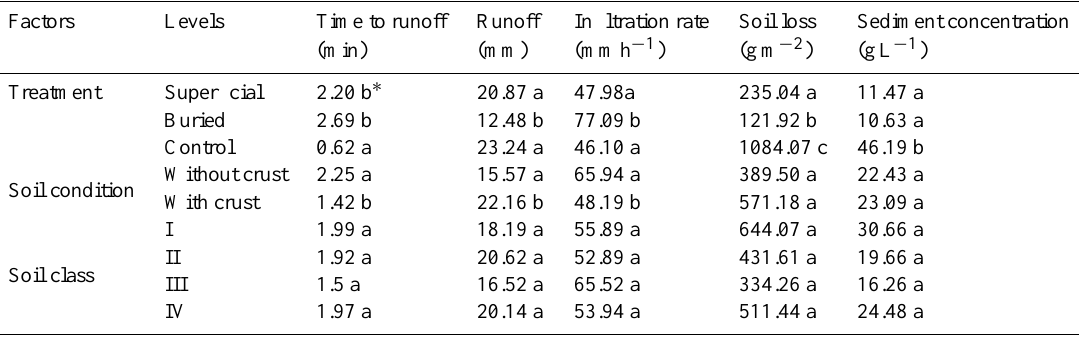
Table 2. Influence of factor levels over the studied parameters (average values). Factors Levels Time to runoff Runoff Infiltration rate Soil loss Sediment concentration (min) (mm) (mmh − 1 ) (gm − 2 ) (gL − 1 ) Treatment Superficial 2.20 b ∗ Buried Without Soil condition